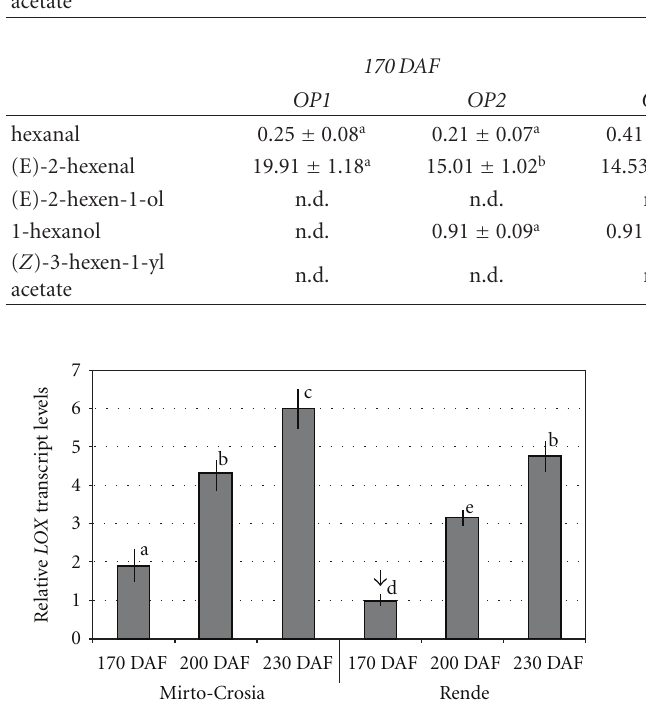
Figure 3: Transcript accumulation of LOX gene in “Coratina” cv fruits harvested at three stages of ripening (170 days after flowering DAF = green mature; 200 DAF = black with < 50% purple flesh; 230DAF = black with > 50% purple flesh) and in two di ff erent cultivation areas (Rende and Mirto-Crosia). To “Coratina” samples collected on the 170 DAF stage, ( ↓ ) was assigned the value of 1.0 and it was used as calibrators. Data are expressed as mean values ± standard deviation of three independent experiments. Duncan test has been used to assess significance ( P = 0 . 05). Values followed by di ff erent letters in the same line are significantly di ff